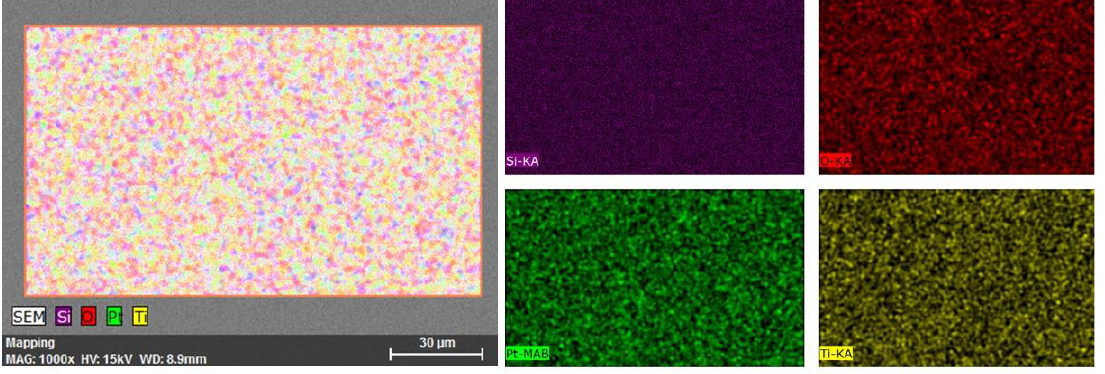
Table 2. EDS elemental analysis for PtTi thin film deposited on a glass substrate.